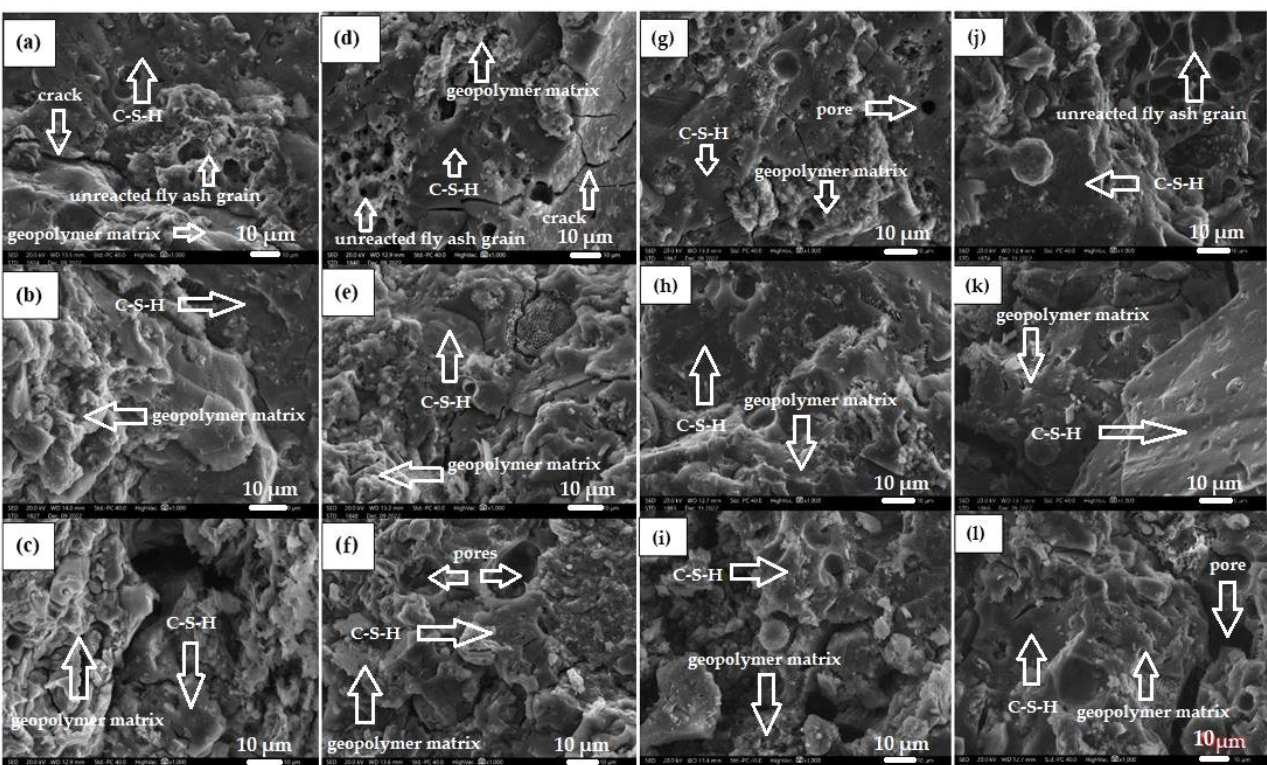
Figure 4. Microstructure of geopolymers in magnification 1000x: ( a ) 10MDN10%, ( b ) 10MDK10%,